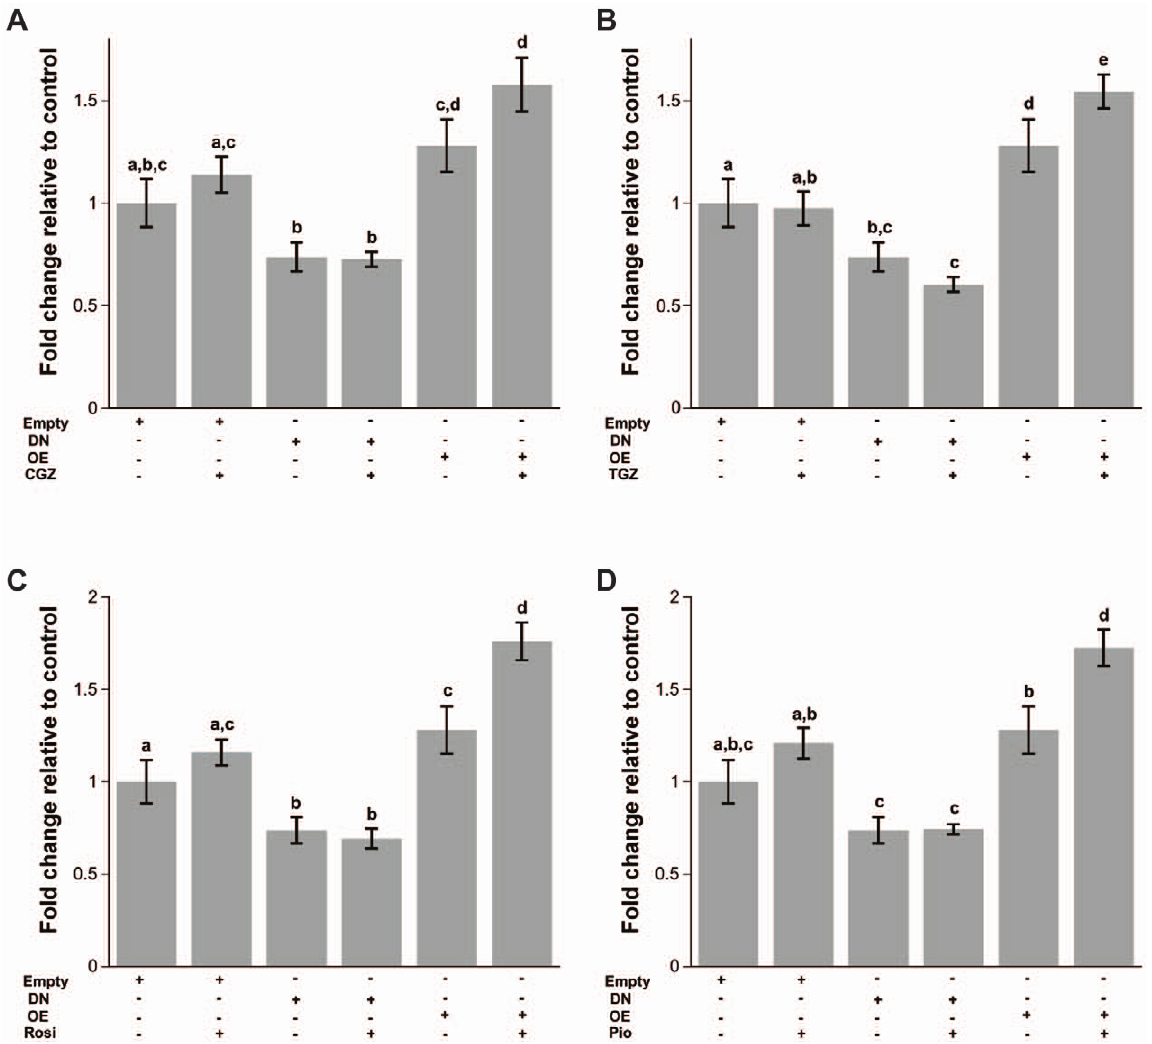
Figure 8. PPRE Luciferase promoter activity assay. Ovcar3 cells were double transfected with a PPRE construct and one of the following: Empty vector, DN, or OE PPAR c . After the double transfections, cells were treated for 24 hours with vehicle control (DMSO) or 10 m M of ( A ) CGZ, ( B ) TGZ, ( C ) Rosi, ( D ) or Pio. Results are the means 6 SEM for at least 3 measurements from three individual experiments. Bars that do not share a letter designation are significantly different ( p ,